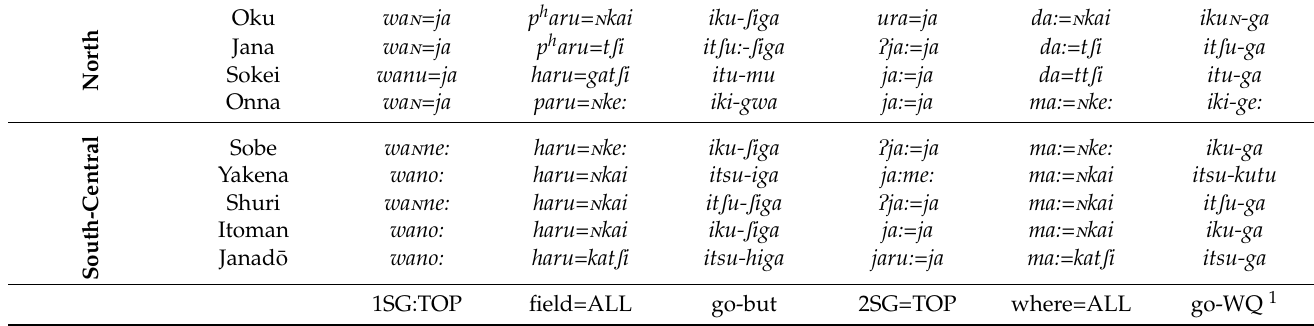
1 Glosses: 1SG = first-person singular pronoun, TOP = topic marker, ALL = allative case marker, 2SG = second- person singular pronoun, WQ = wh-question